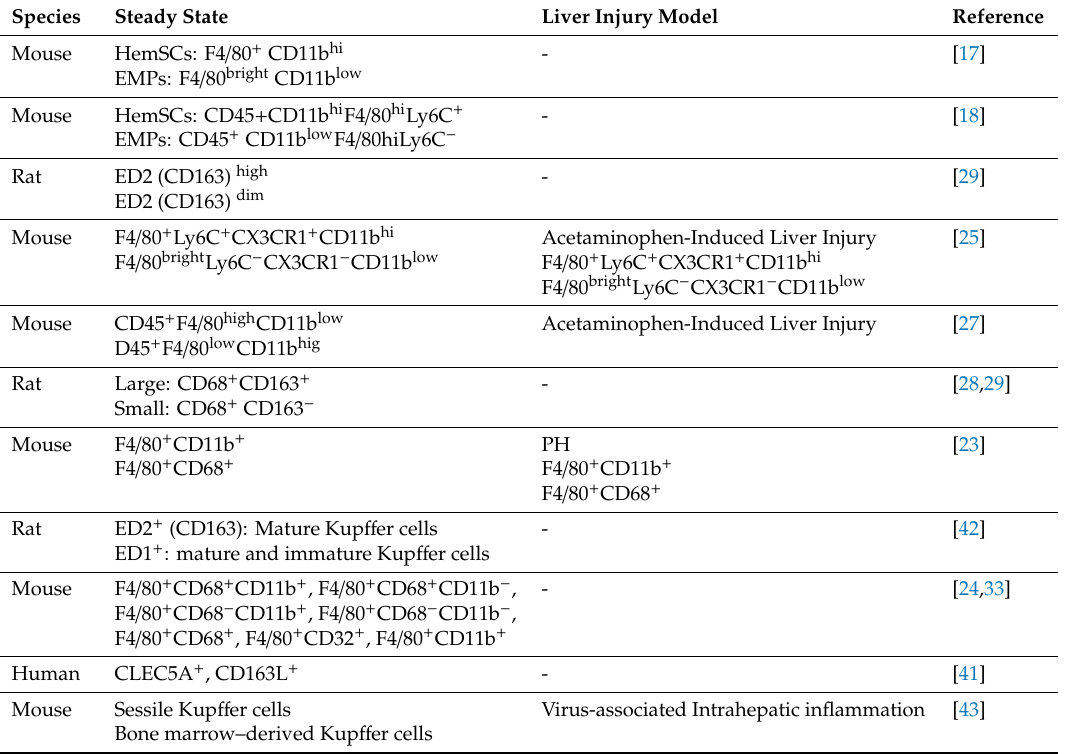
Figure 1. Sources of development and immunophenotype of a subpopulation of liver macrophages. Table 1. Liver macrophages subpopulations.